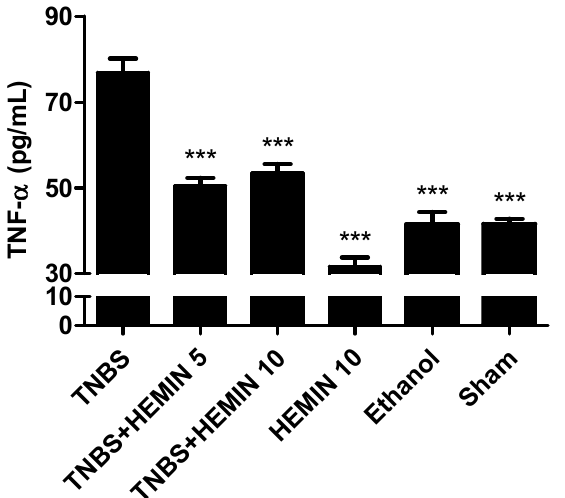
Figure 5. Effect of hemin treatment on TNF- α concentration in the IBD. Legend: One-way ANOVA for multiple comparisons and Tukey’s post hoc test. *** p < 0.001; compared with TNBS group.